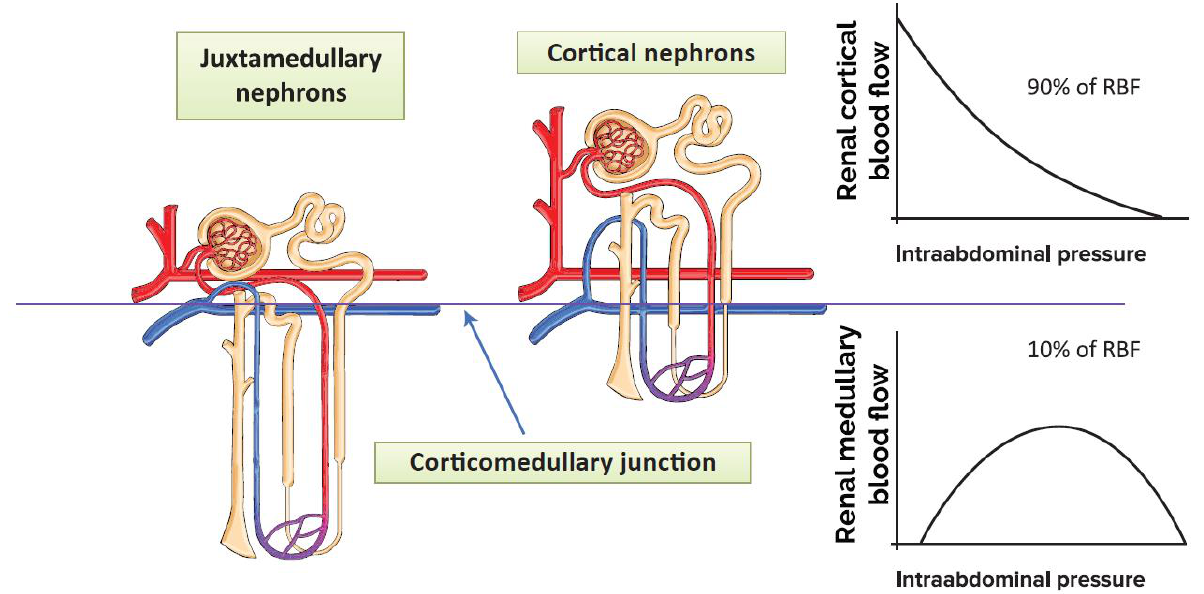
Figure 3. The different effects of elevated intra-abdominal pressure on cortical and medullary blood flow. Red vessels: arteries; blue vessels: veins; purple vessels: connection vessels between arteries and veins; yellow tubes: urine conducting system (Re-drawn with permission of Publisher, from [56]).